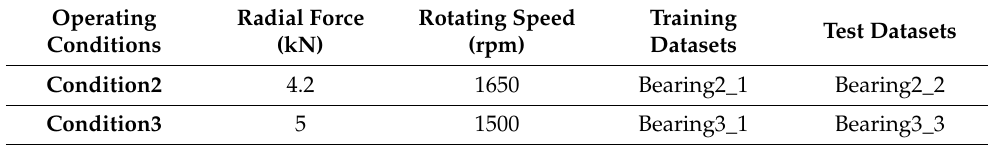
Table 1. Datasets used in experiments.